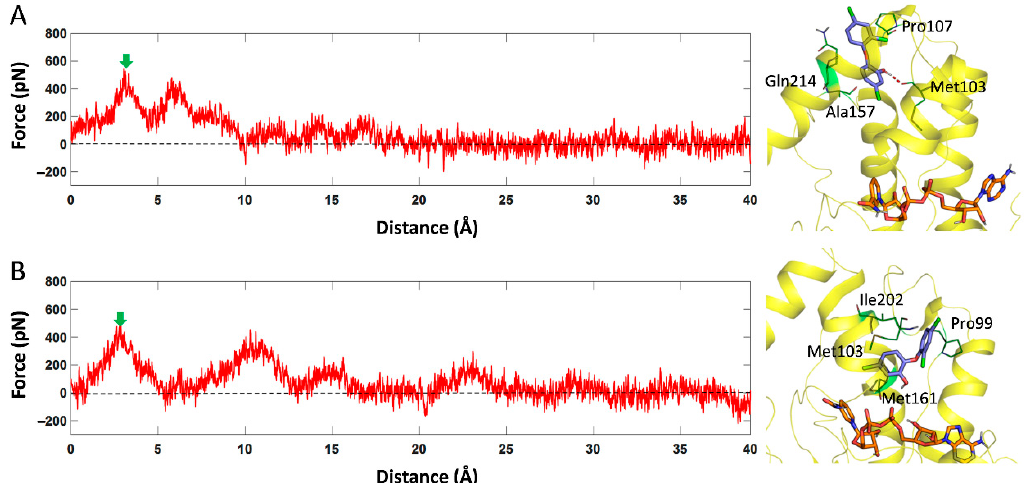
Figure 6. The force profile of TCL over the reaction coordinate along path1 channel ( A ) and path2 channel ( B ). The structures at the maximum force (green arrow) were extracted and displayed on the right side of the picture.